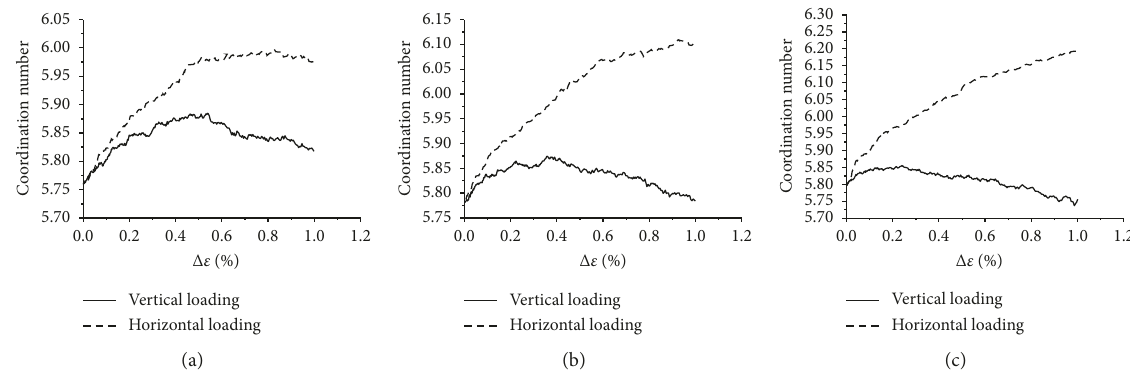
Figure 11: Curves of the average coordination number: (a) sample group A; (b) sample group B; (c) sample group C.